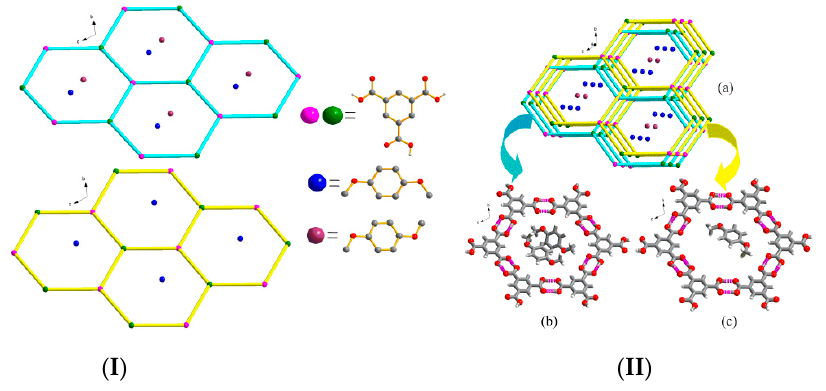
Figure 2. ( I ) DMB molecules located in the channels formed hydrogen-bonded 6-membered rings in compound ( 2 ); ( II ) two hydrogen-bonded 6-member rings in compound ( 2 ).